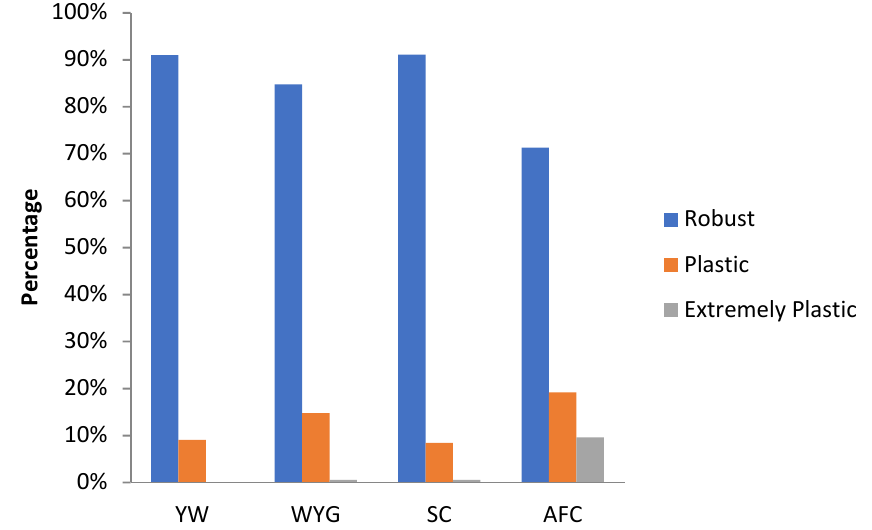
Figure 9. Percentage of animals with different genotypes (robust, plastic, and extremely plastic), for yearling weight (YW), weaning to yearling weight gain (WYG), scrotal circumference (SC) and age at first calving (AFC), considering the reaction norm models (RNM) fitted with spline linear–linear heteroscedastic